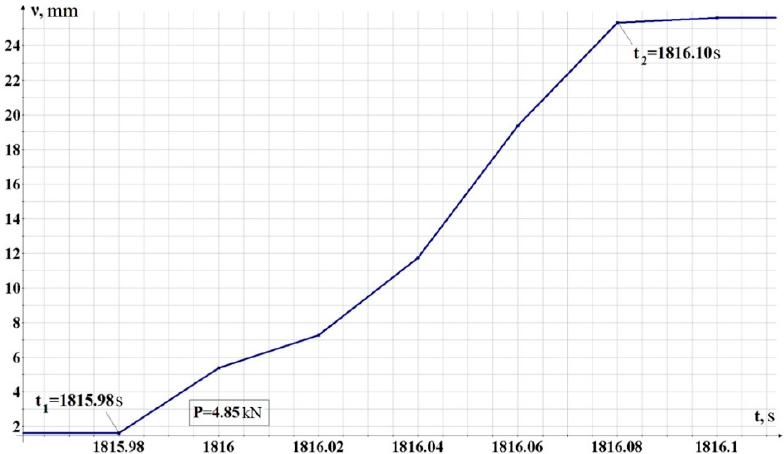
Figure 20. Change in the de fl ection of the truss, mm ( y -axis) in time, s ( x -axis) in the phase of de- struction of the lower belt (P = 4.85 kN). Experiment No.